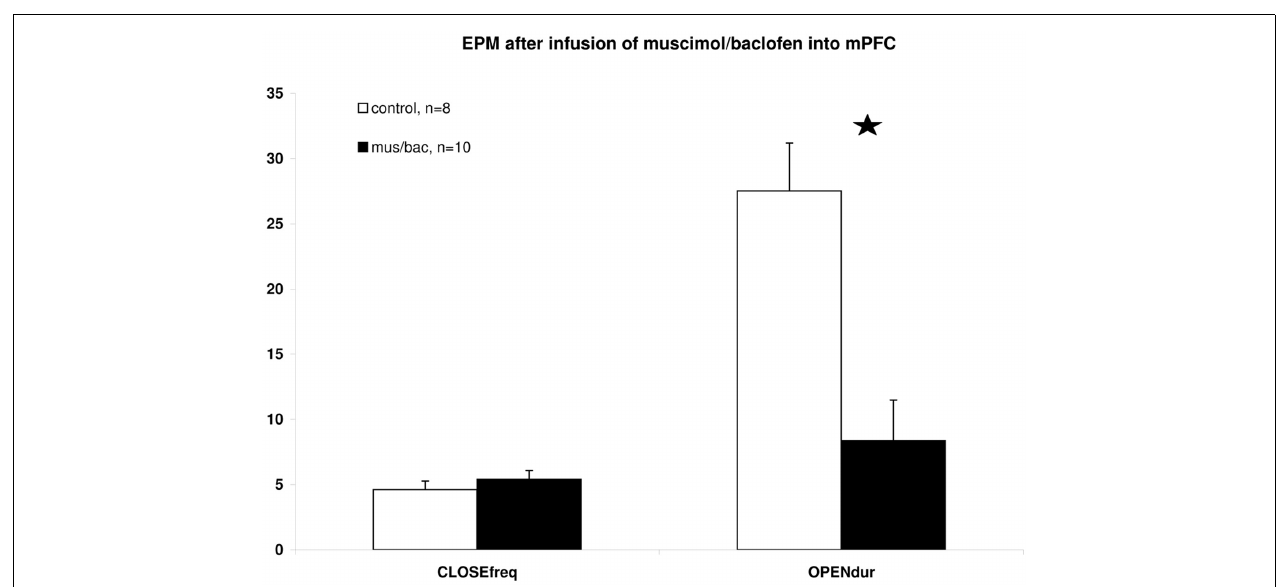
FIGURE 2 | Differences in EPM behavior between mPFC saline injected and MSM/BAC injected rats. CLOSEfreq = the number of closed arm entries, OPENdur = the time spent on one of the open arms as a percentage of total observation time. Shown are means ± SEMs, * p ≤ 0.01 between groups.